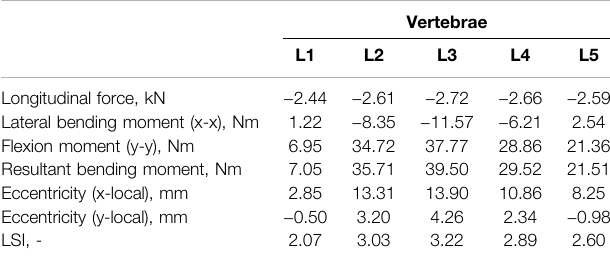
Vertebrae L1 L2